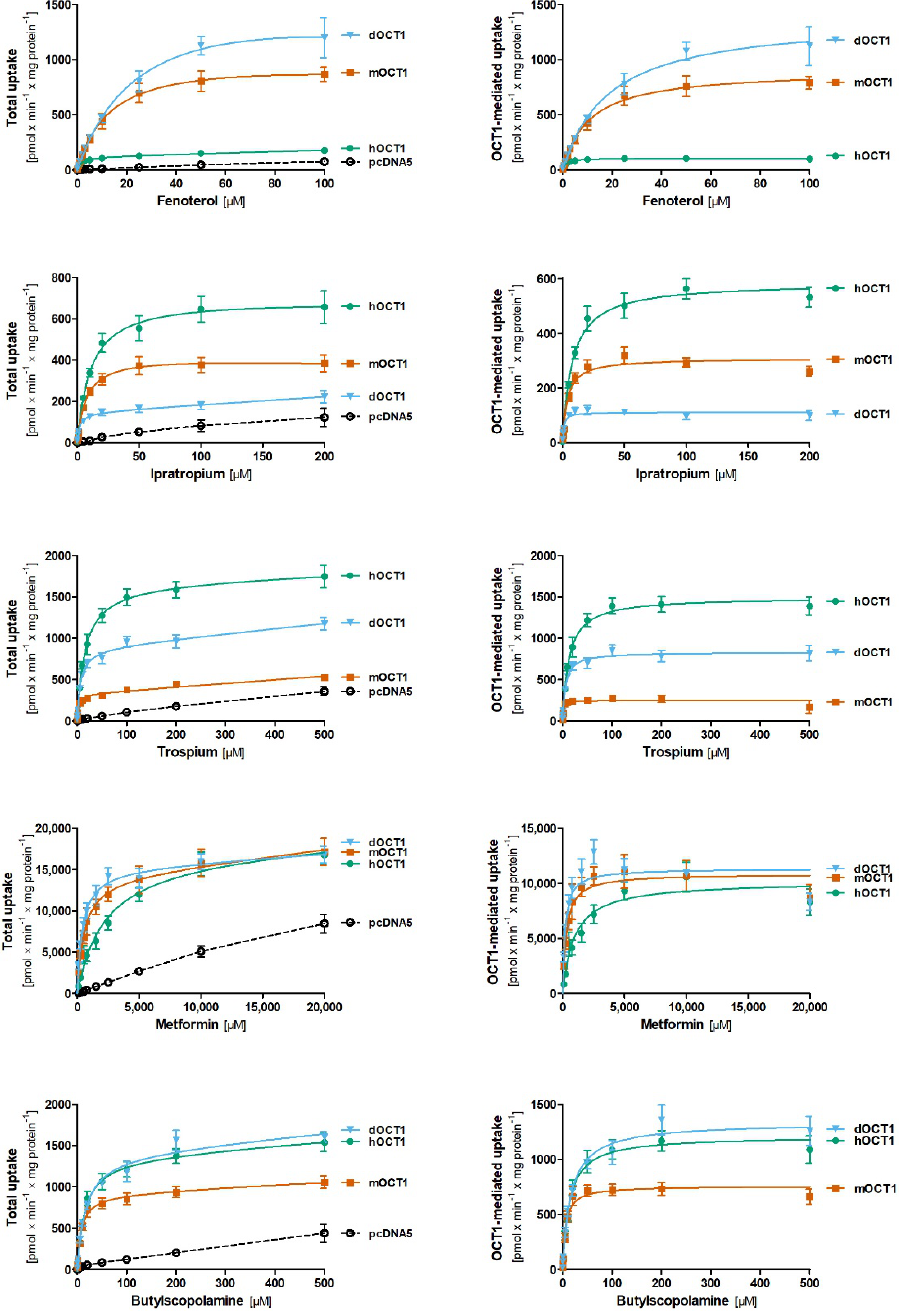
Figure 4. Comparative characterization of substrate uptake between dog, human, and mouse OCT1 orthologs. HEK293 cells stably transfected to overexpress dog (blue), human (green), and mouse (red) OCT1 were incubated for 2 min with increasing concentrations of fenoterol, ipratropium, trospium, metformin, and butylscopolamine. The total uptake is shown for the overexpressing and control cells (left hand side). OCT1-mediated uptake (right hand side) was calculated by subtracting the uptake of control cells (pcDNA5) from the uptake of OCT1-overexpressing cells. The means and standard errors of the means are shown for at least three independent experiments. An Eadie–Hofstee transformation of the data is shown in Figure S3.